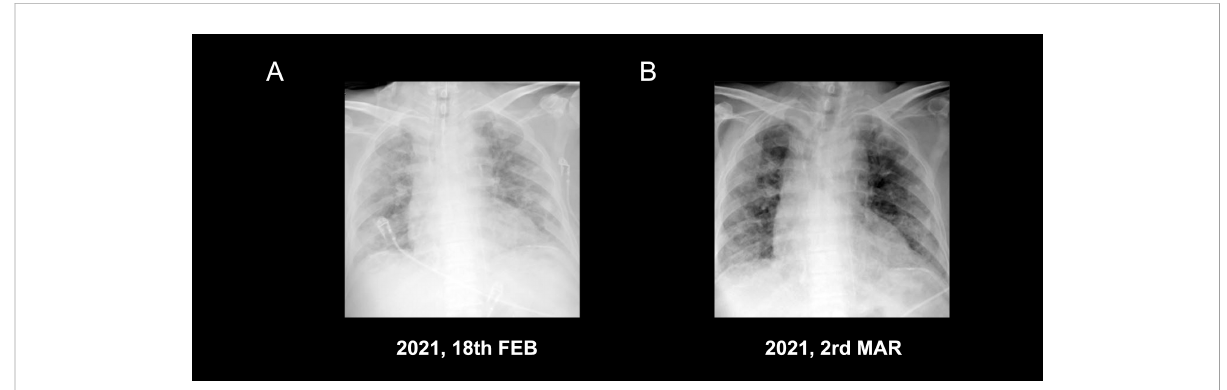
FIGURE 4 Bedside chest radiograph: both lung translucency and consolidation shadow decreased after treatment (A, B)